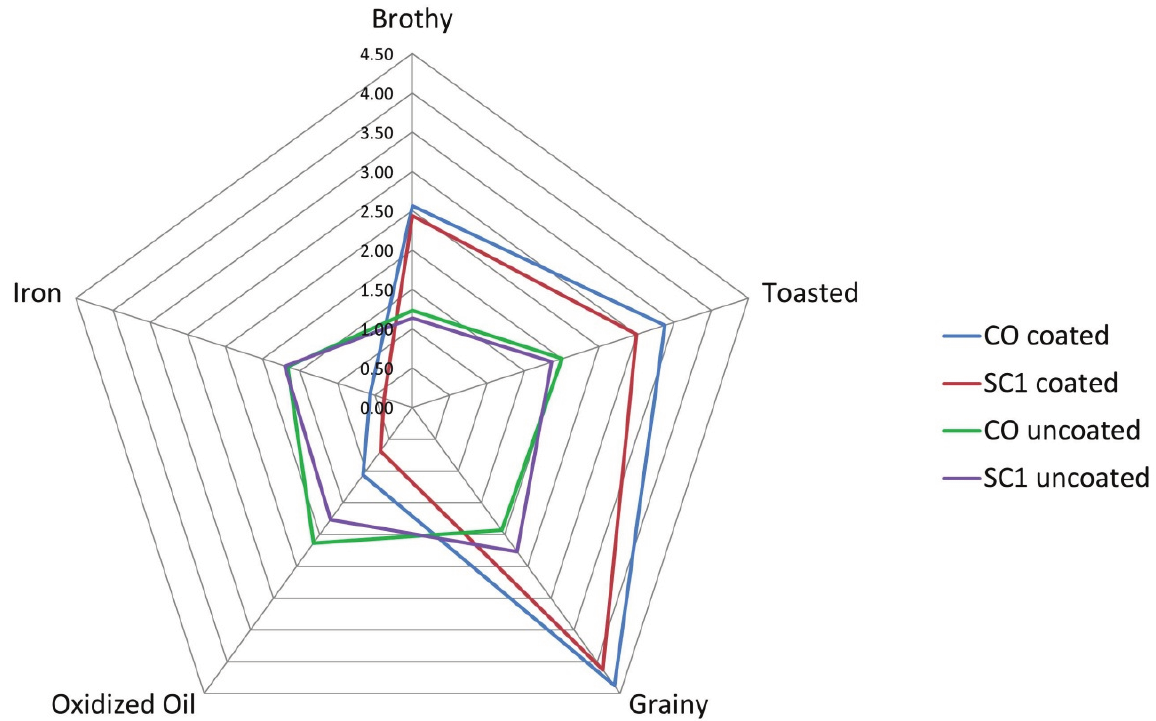
Figure 1. Poultry fat and palatant effect on kibble aromatics. Only the Control (CO) sample and Sugar Cane large particles (SC1) samples are shown.